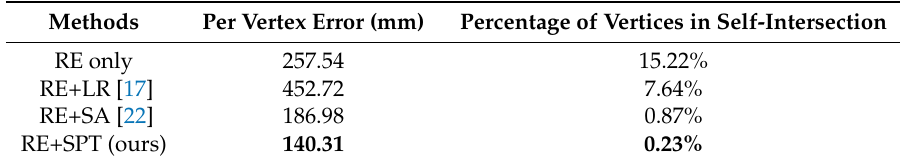
Table 1. Results of baseline method, other state-of-the-art methods and our proposed approach on reduced test set of UP-3D [24].